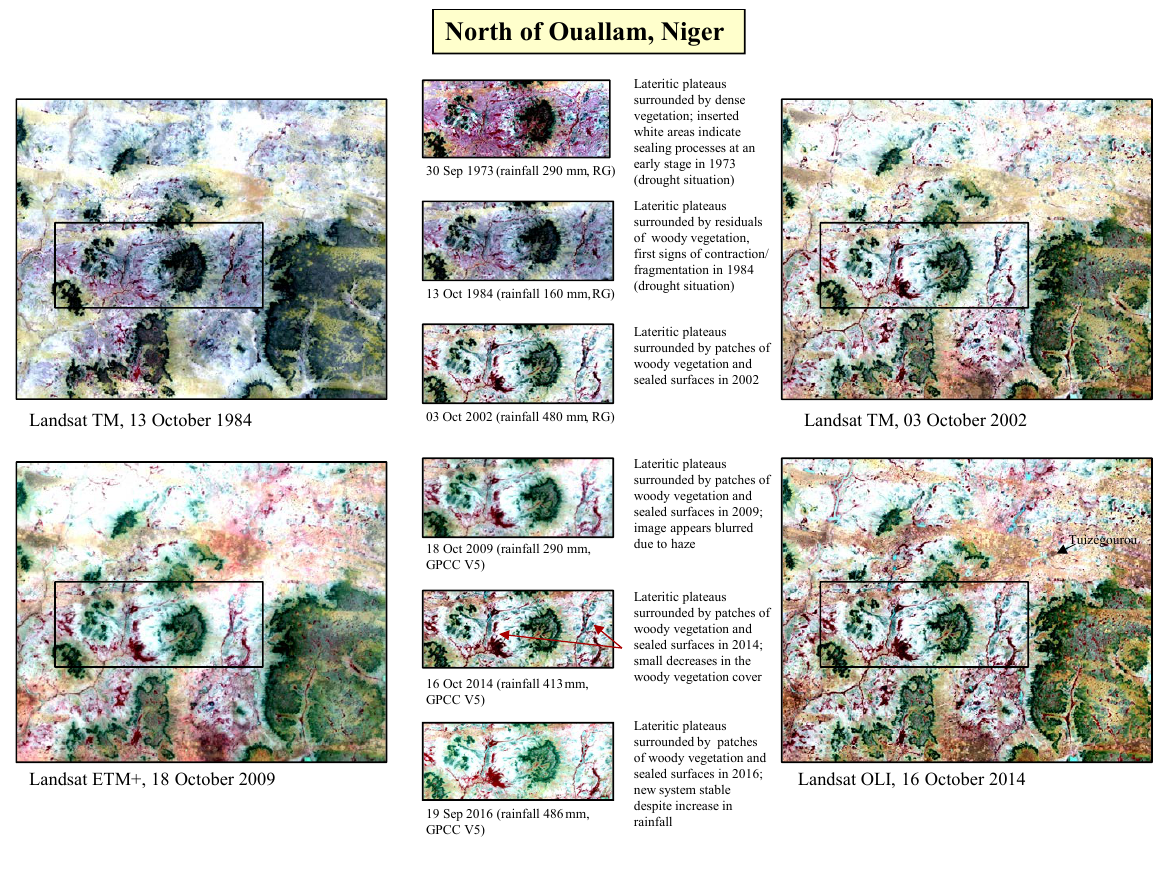
Figure 16. Pattern sequence of a research site in western Niger (north of Ouallam).